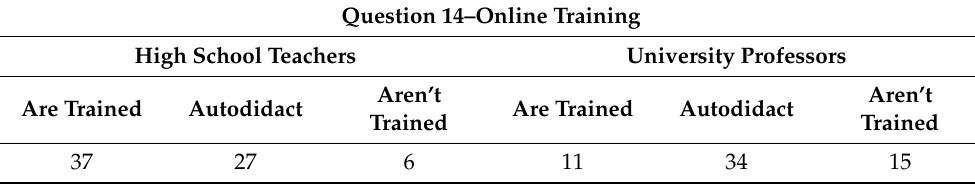
Table 6. Teachers’ and pedagogues’ online training.